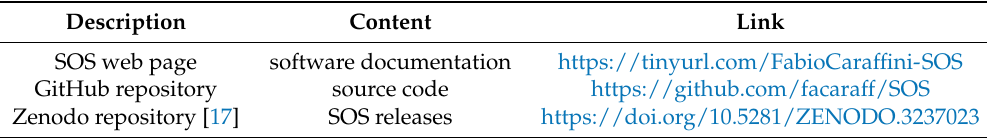
Table 1. Relevant links to source code and software